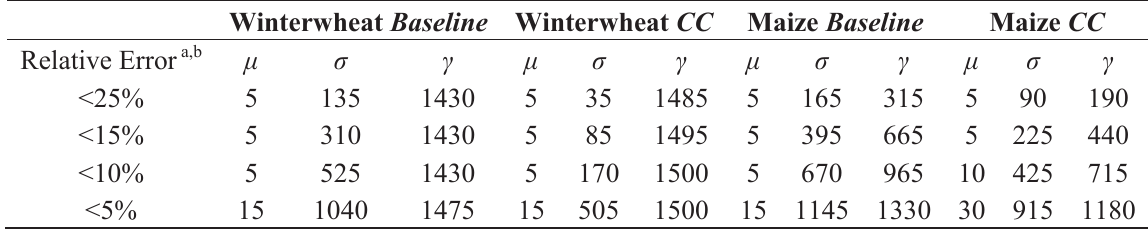
a All values shown in Table 3 correspond to the 95%-quantile. b (cid:541) = mean yield; (cid:305) = standard deviation of yields; (cid:534) = skewness of yields.